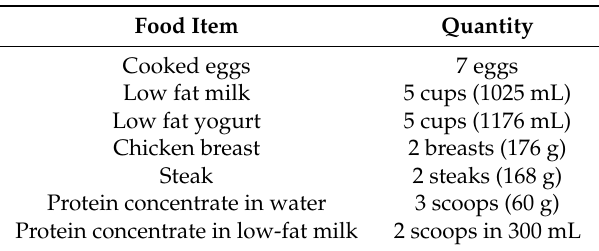
Table 1. Quantity of protein sources to provide 40 g pre-sleep